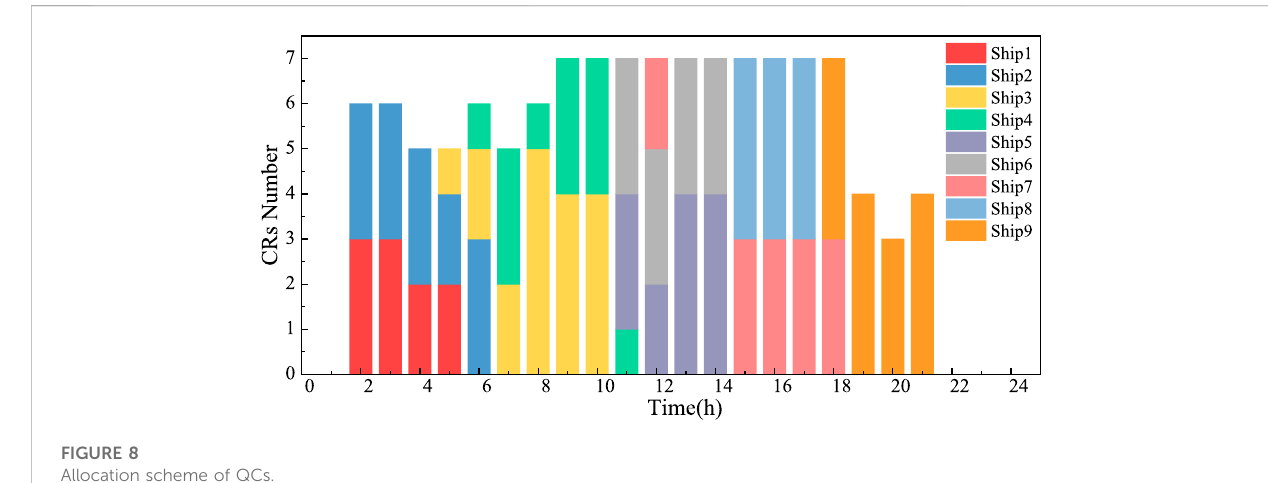
FIGURE 8 Allocation scheme of